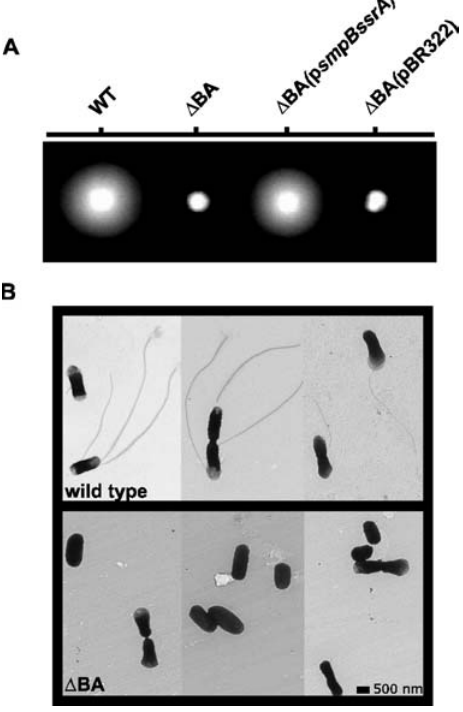
Figure 10. The D BA Mutant Has Impaired Motility (A) An equal number of cells from each bacterial strain were inoculated onto 0.25% agar-T medium plates and incubated for 48 h at room temperature. (B) Wild-type and mutant cells were immobilized on grids, negatively stained with phosphotungstic acid, and analyzed using a JEOL JEM- 1200EX II transmission electron microscope. Magnification ¼ 12,000 3 ; scale bar ¼ 500 nm. WT, wild type. DOI: 10.1371/journal.ppat.0020006.g010